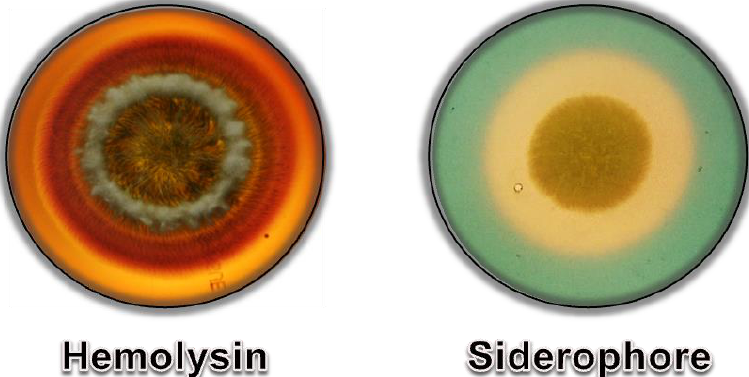
Figure 10. Production of hemolysin and siderophores by S. apiospermum . Left : Plate of Sabouraud medium supplemented with 7% sheep blood presenting a 7-day growth of S. apiospermum surrounded by a halo indicating hemolytic activity. Right : Plate of Sabouraud medium supplemented with chrome azurol S (CAS) and iron III solution presenting a 7-day growth of S. apiospermum surrounded by a halo indicating iron chelation.